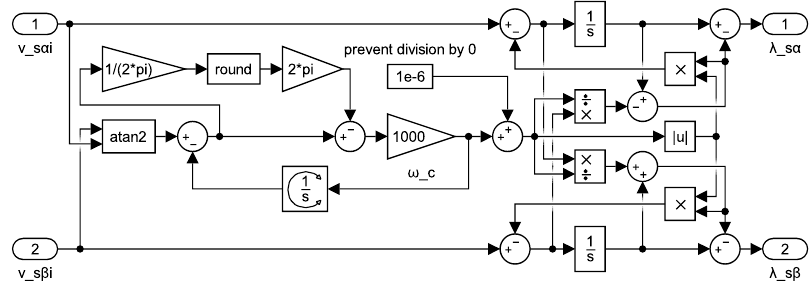
Figure 9. The block diagram of the proposed compensation of the integrational drift used for simulations in MATLAB